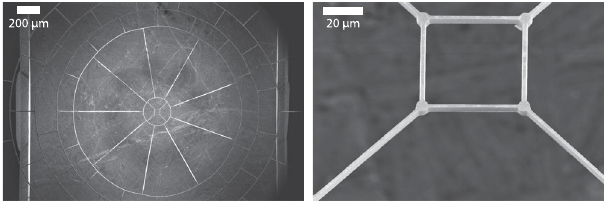
FIG. 3. Scanning electron microscope images of the free- standing wire scanner device. Nine radial wires which are used for the wire scans are supported by a spiderweb-shaped structure attached to a silicon frame. At the center of the geometry a square simplifies the alignment of the wire scanner with respect to the electron beam. Scanning the square horizontally and vertically across the beam provides 4 distinct peaks (for beam sizes smaller than 50 μ m). The center of the geometry can be referenced to the hexapod coordinate system from the location of these